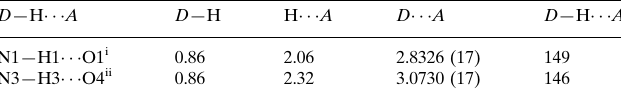
Hydrogen-bond geometry (A˚ , (cid:1)